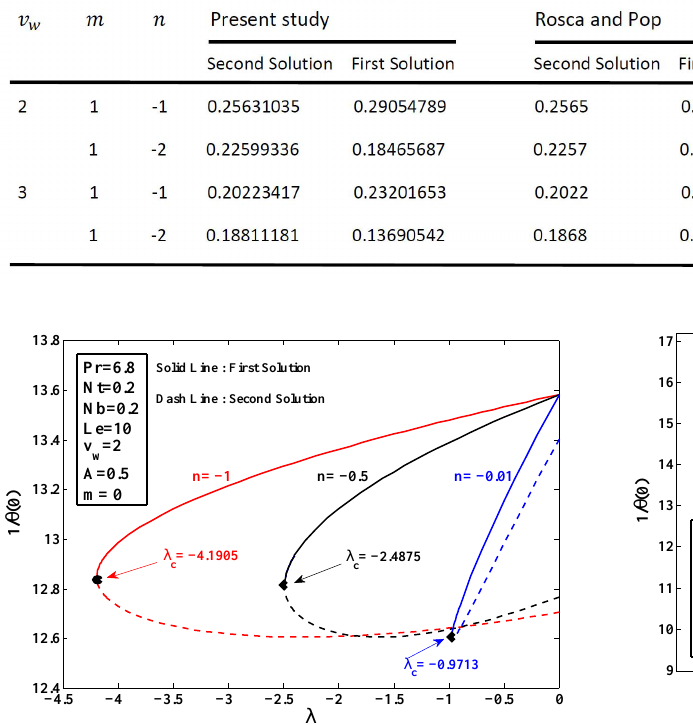
Figure 7: Variation of 1/ θ (0) with the shrinking parameter λ for different values of transpiration rate parameter V w .